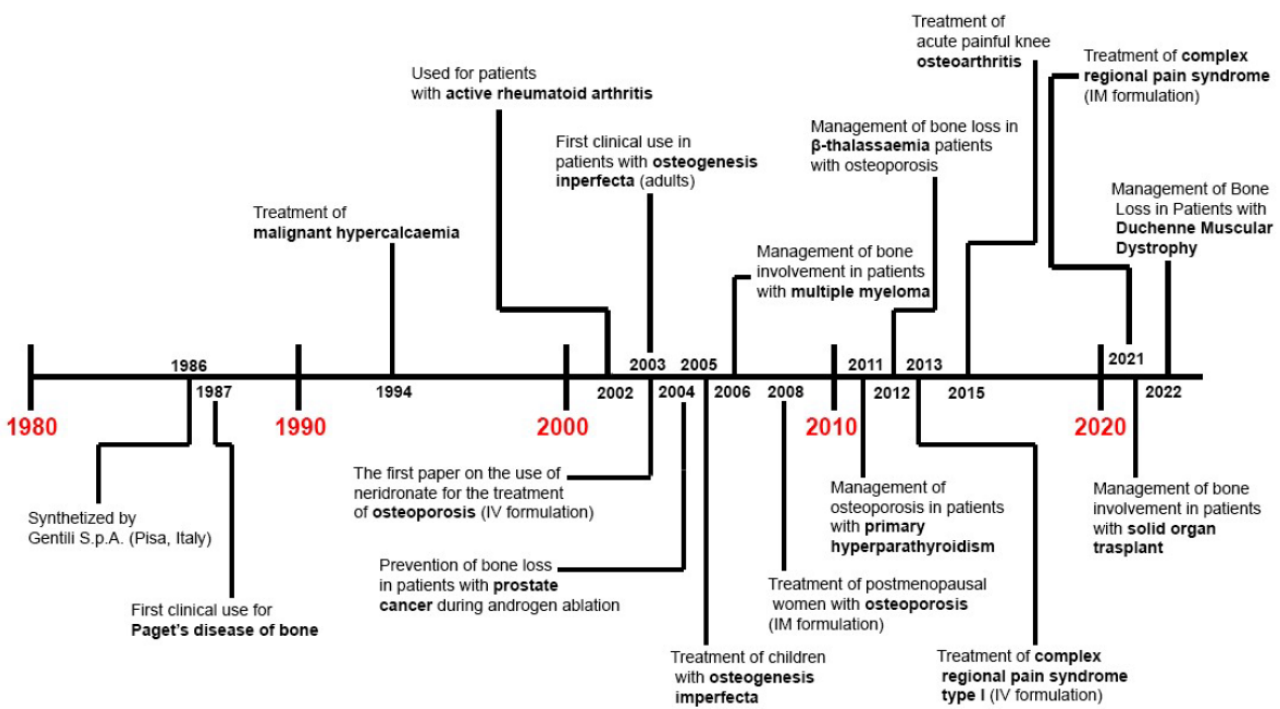
Figure 1. Roadmap of clinical use of neridronate.